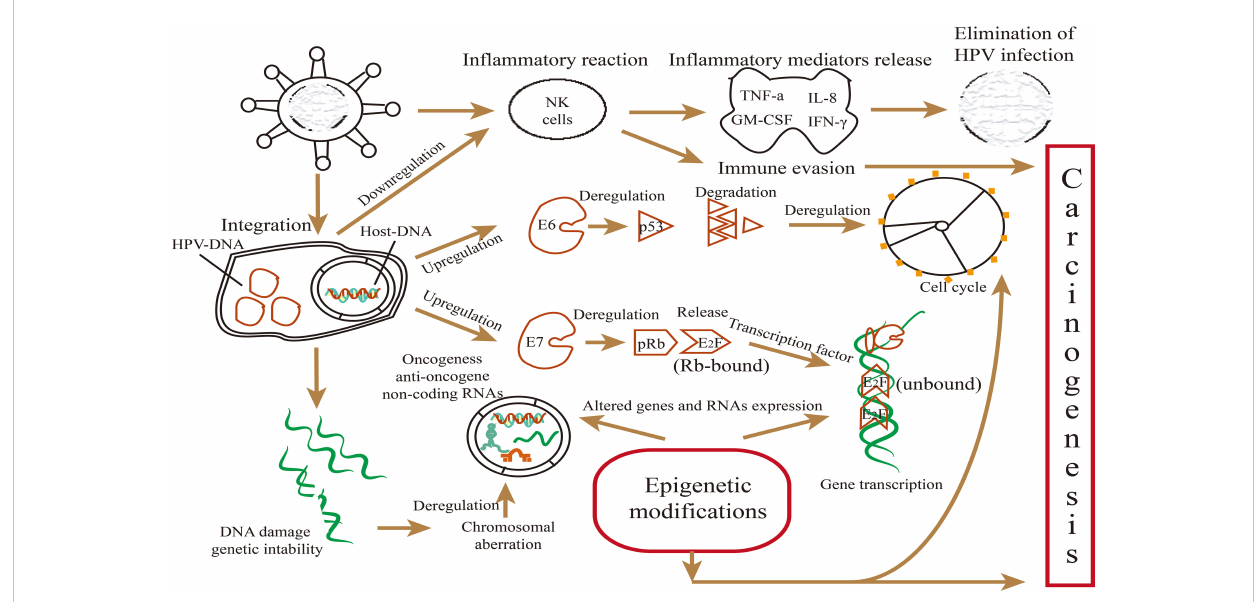
FIGURE 2 Main mechanisms involved in the malignant transformation and biological behaviors induced by viral oncoproteins E6/E7 in HPV-positive HNSCC. Oncoproteins E6 and E7 can inactivate tumor suppressor proteins p53 and pRb involved in the cell cycle, genome stability, and epigenetic modi fi cations, as well as affect mutation and epigenetic changes of the host genome. E6 and E7 regulated the levels of miRNAs mainly by releasing p53 and E2F, thus, affecting miRNA expression, while miRNAs can activate or suppress downstream genes and key signal pathways involved in biological